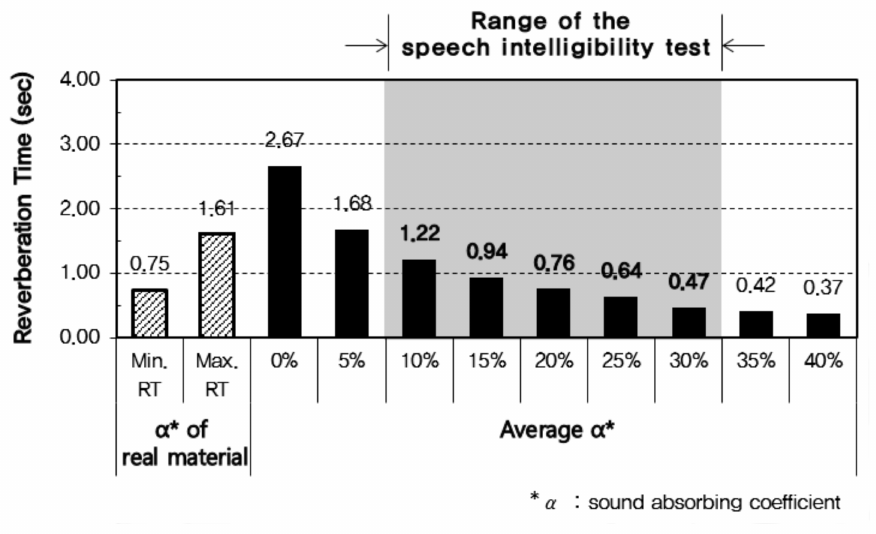
Figure 5. Differences of acoustical parameters in the various conditions of Korean classrooms. The vertical axis of Figure 5 represents the average reverberation time (RT mid ) of mid-frequency that affects speech recognition most. The grey bars describe the maximum difference of reverberation times of simulated Korean standard classrooms. When all the possible sound absorption materials could be practically applied, RT mid was 0.75 s while 1.61 s could be obtained when minimum sound absorption materials were used. The black bars present the deviation of the reverberation times, which were changed by various average sound absorbing coefficients of rooms. The same sound absorption coefficient ( α ) was applied to all frequency bands during the